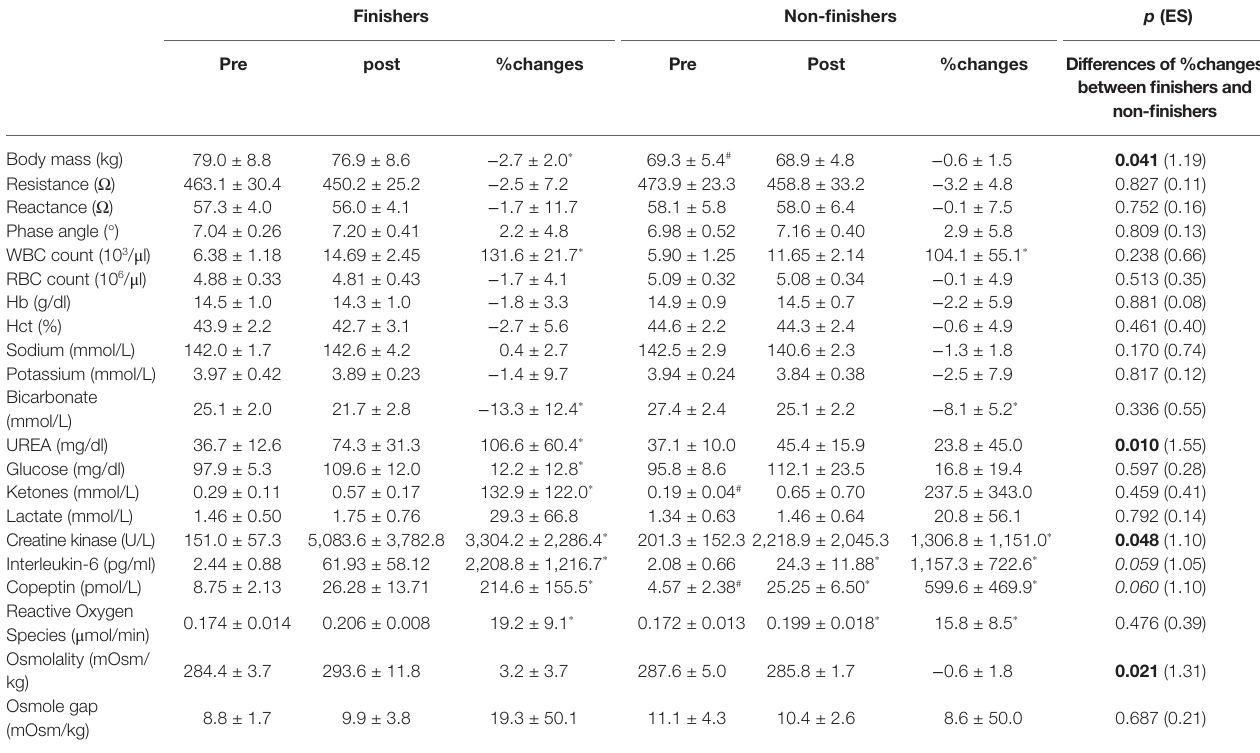
TABLE 3 | Changes in measured variables of the finishers and non-finishers of the long mountain ultra-marathon running race ( n = 7 and n = 8 for the finishers and the non-finishers,